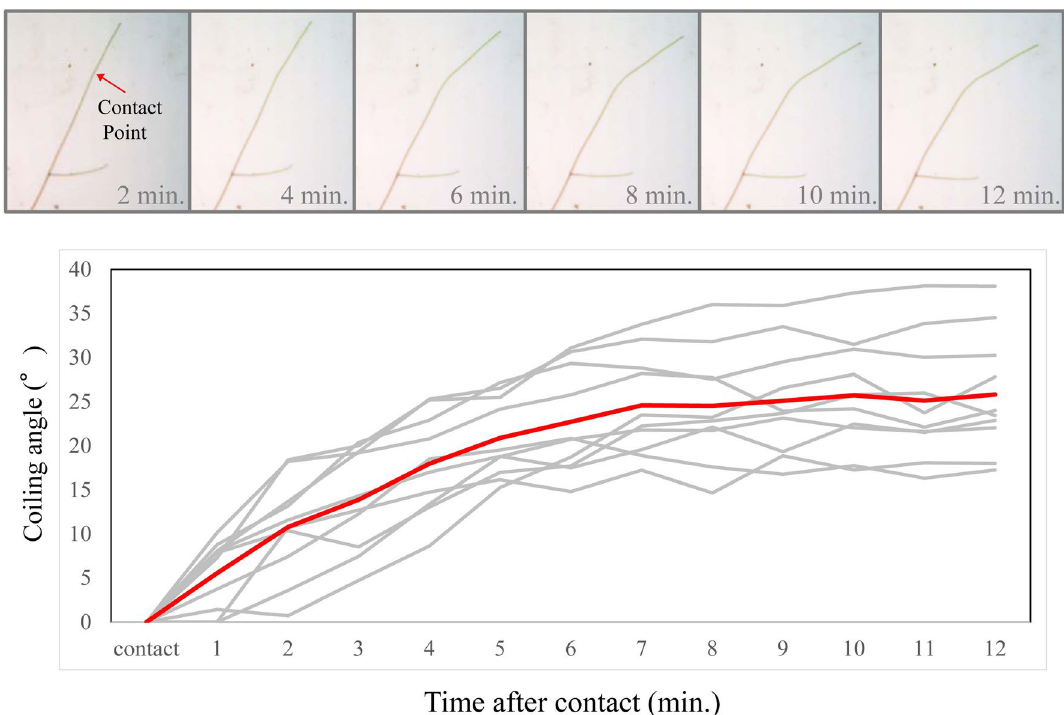
Figure 4. Change in coiling angle after contact. ( Top ) A representative picture of temporal change in coiling angle. ( Bottom ) Temporal changes in coiling angle. Gray lines represent the change in coiling angle of each tendril (n = 10) and red line represent the